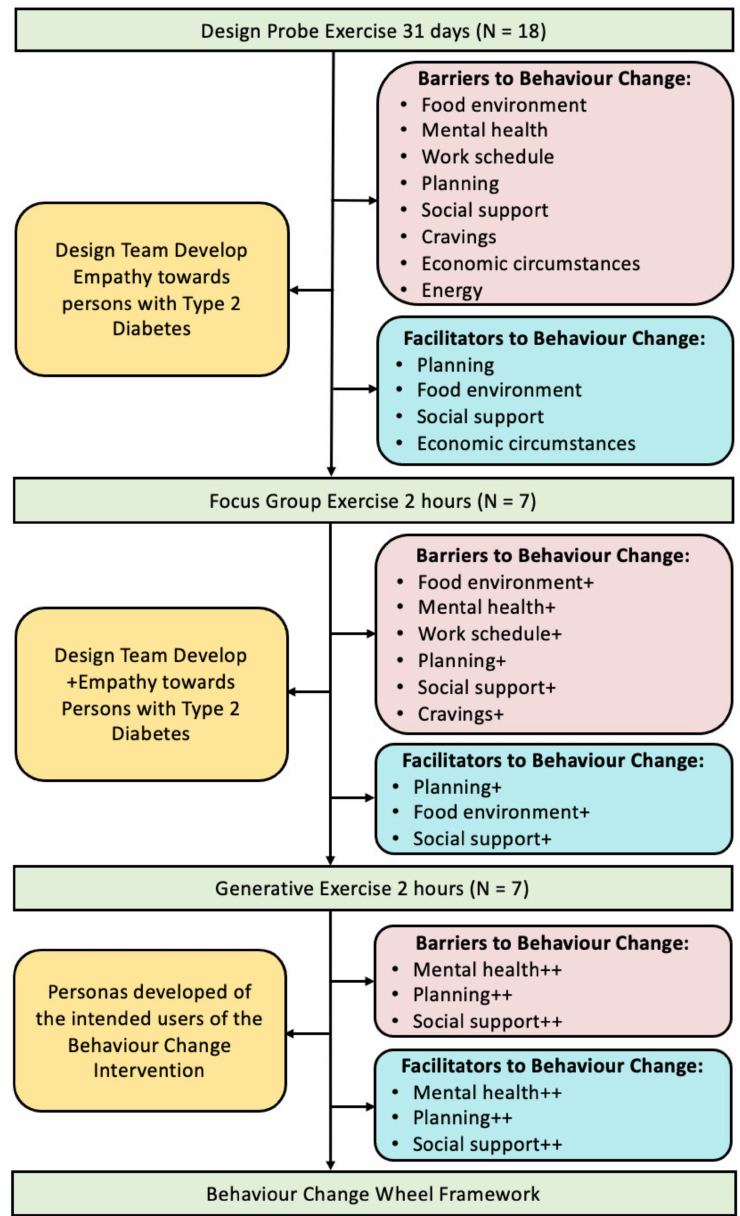
Figure 7. Summary of outcomes of the user research processes. The + denotes which barrier and facilitator themes were further reinforced in the focus group exercises. The ++ denotes which barrier and facilitator themes were again further reinforced in the generative